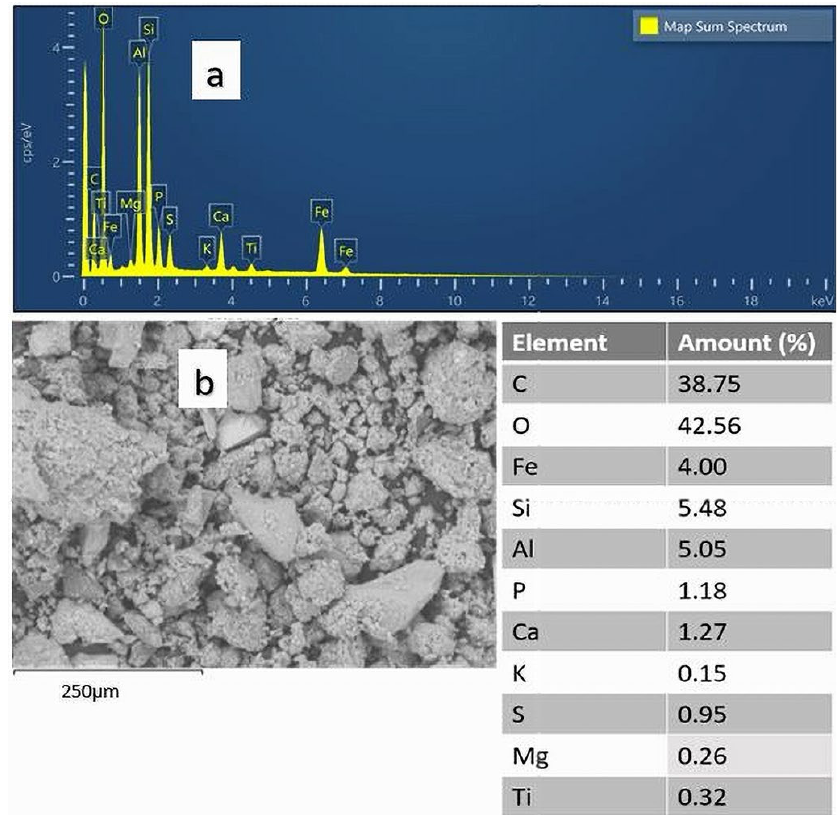
Figure 2. SEM-EDX analysis of biochar. ( a ) SEM micrograph; ( b ) EDX analysis including tabulated elemental composition below the figure.